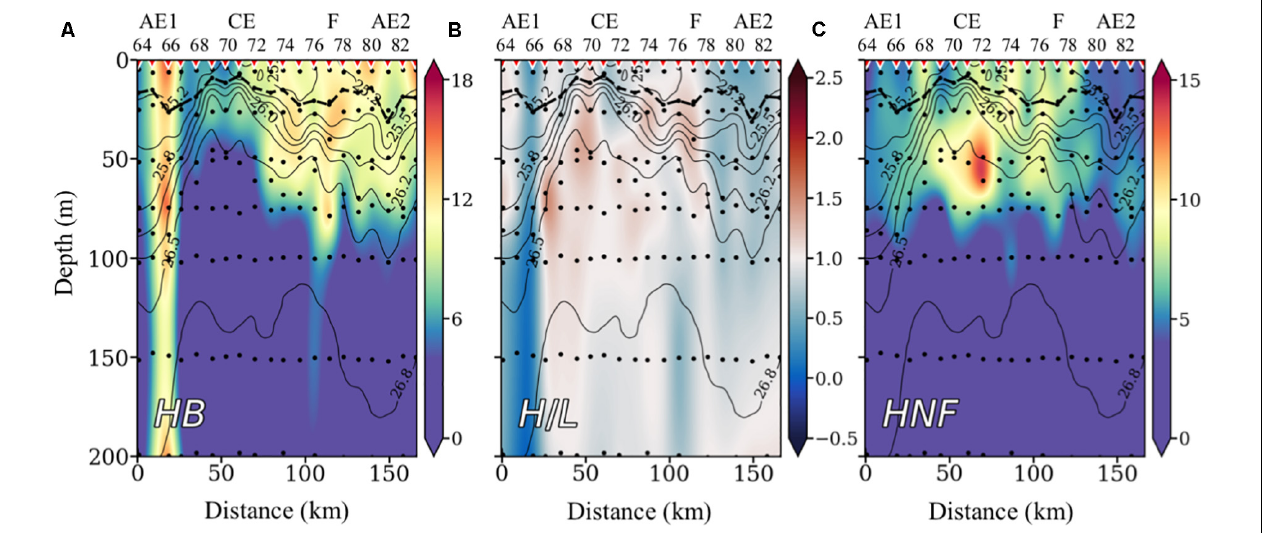
FIGURE 6 | Vertical distribution of heterotrophic bacteria (HB) biomass concentration in µ g C · m − 3 (A) , the ratio HNA/LNA (B) , and heterotrophic nanoeukaryotes (HNF) biomass concentration in µ g C · m − 3 (C) ; all with isopycnals superimposed. Inverted red triangles on the top axis indicate stations position. The locations of the anticyclonic eddies (AE), the cyclonic eddy (CE), and the filament (F) are also indicated on the top axis. The bold black line shows the depth of the mixed layer (MLD). Black dots indicate sampled depths. Note that scales are different for the HB and NEuk